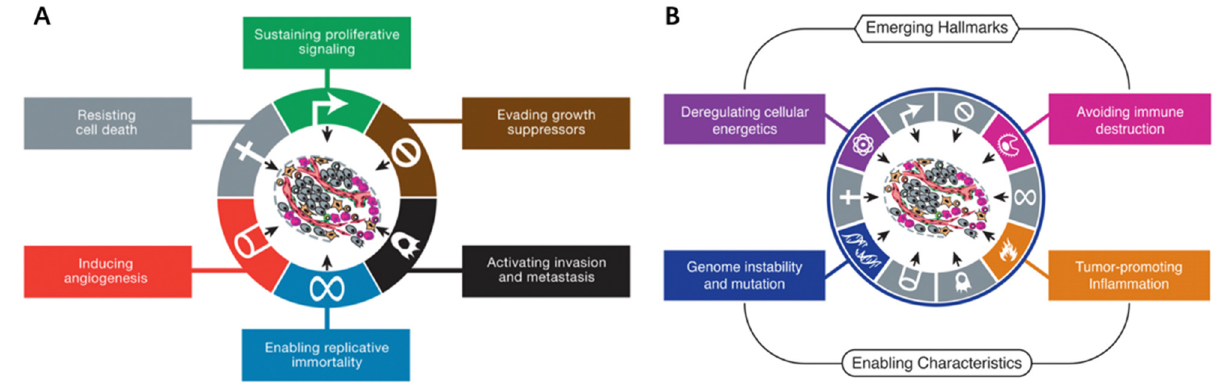
Figure 2. ( A ) The six hallmark traits originally proposed in 2000. The past decade witnessed remarkable progress toward understanding the mechanistic underpinnings of each hallmark. ( B ) Emerging Hallmarks and Enabling Characteristics. Reproduced with permission from [10]. 2011, Elsevier.